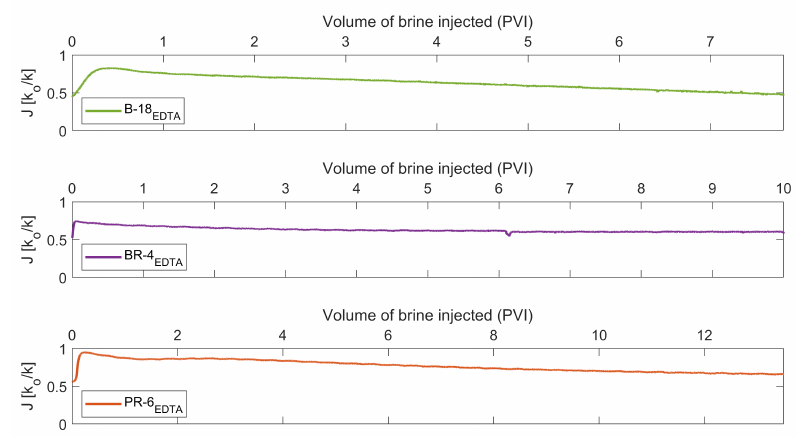
Figure 13. The impedance change for 2D*TB into core plugs flooded previously with EDTA. Berea (green line), Bandera Brown (purple line), and Parker (orange line)